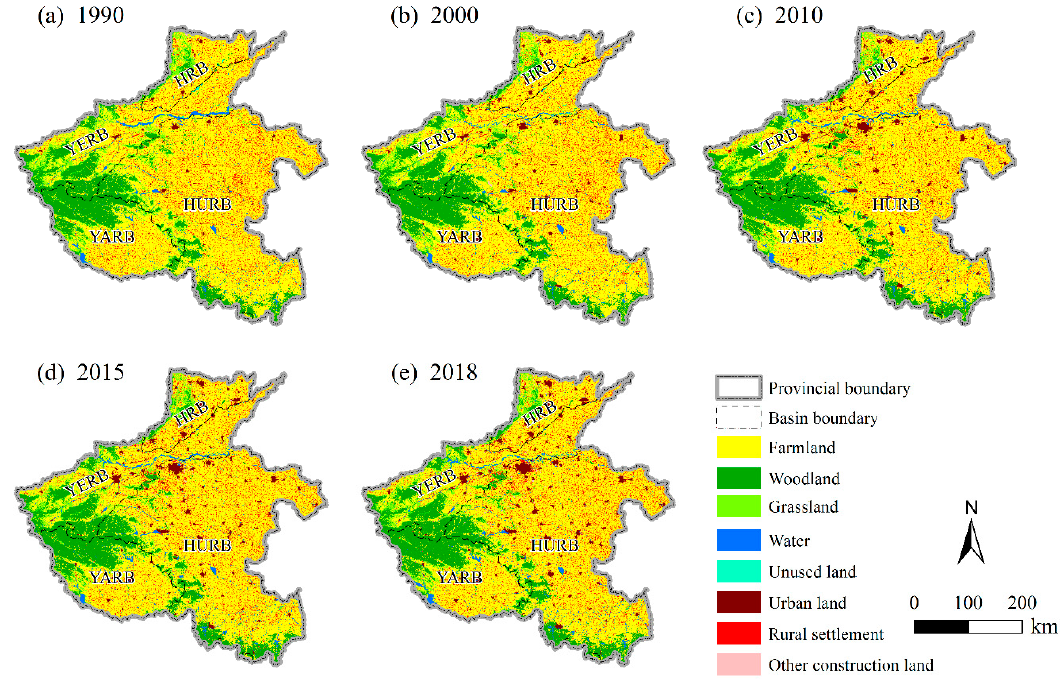
Figure 2. Land-use status in 1990 ( a ), 2000 ( b ), 2010 ( c ), 2015 ( d ), and 2018 ( e ) in Henan Province. Table 3. Area and proportion of land-use types in the study area in 1990, 2000, 2010, 2015, and 2018.